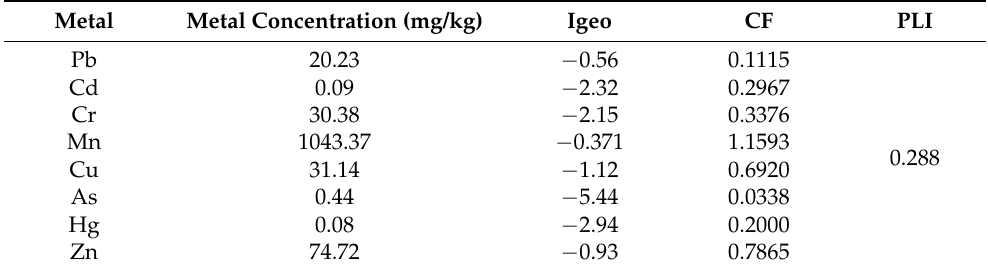
Table 3. Environmental health-related hazard indices for metal concentration in